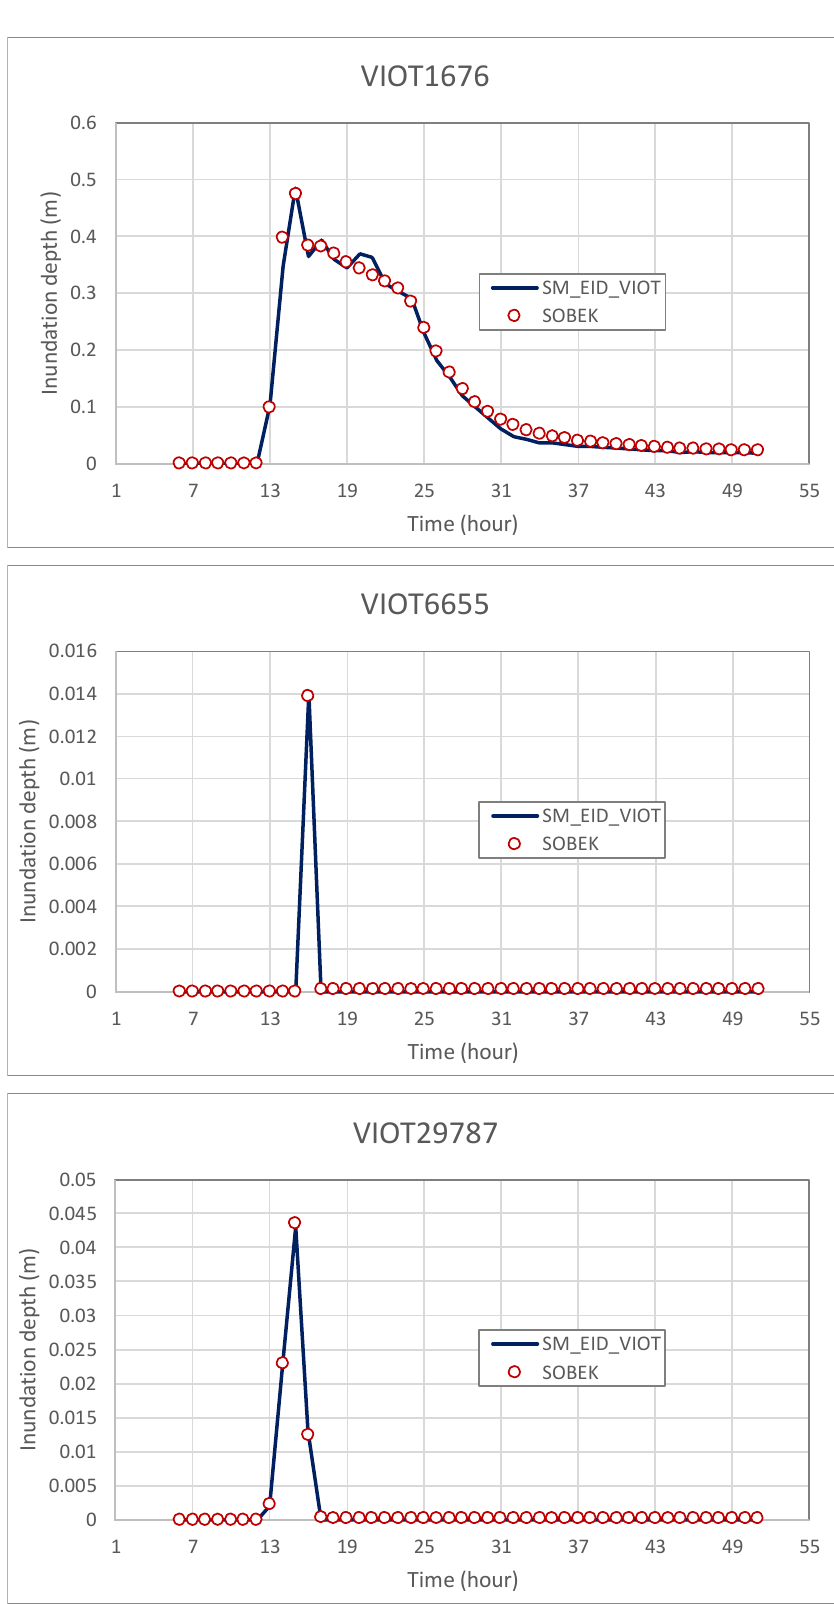
Figure 20. Comparison of the resulting inundation-depth hydrograph at the specific VIOT grids from the proposed SM_EID_VIOT model with the validated data.